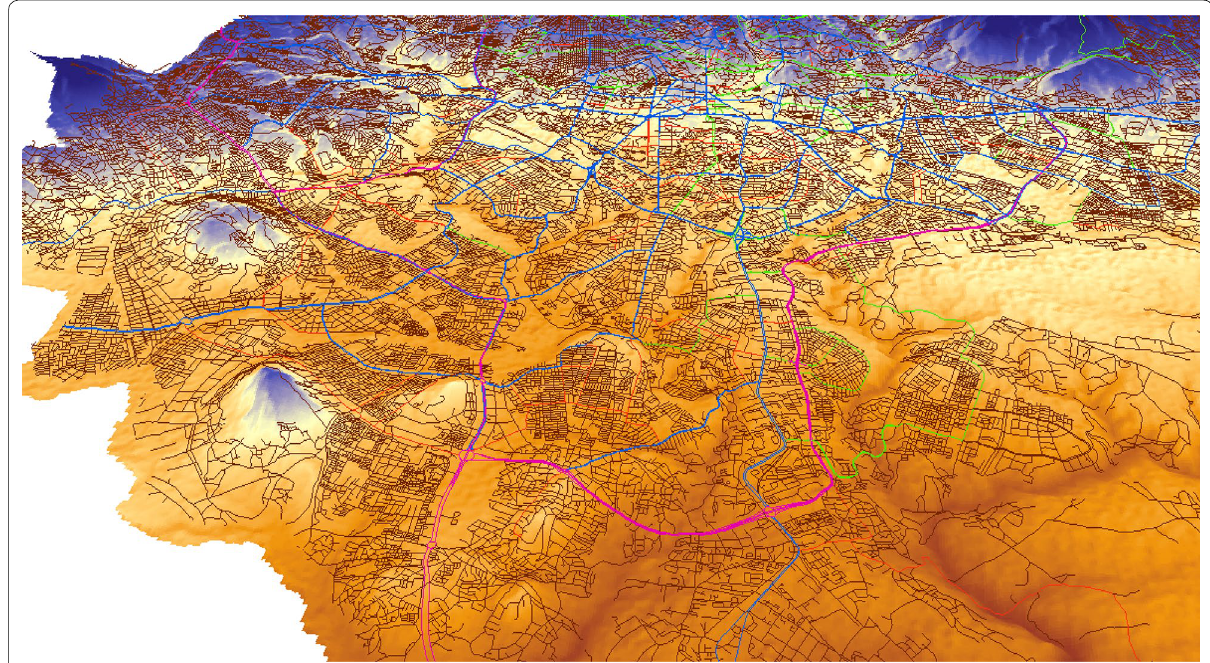
Fig. 3 A 3D digital model of Addis Ababa city showing its road